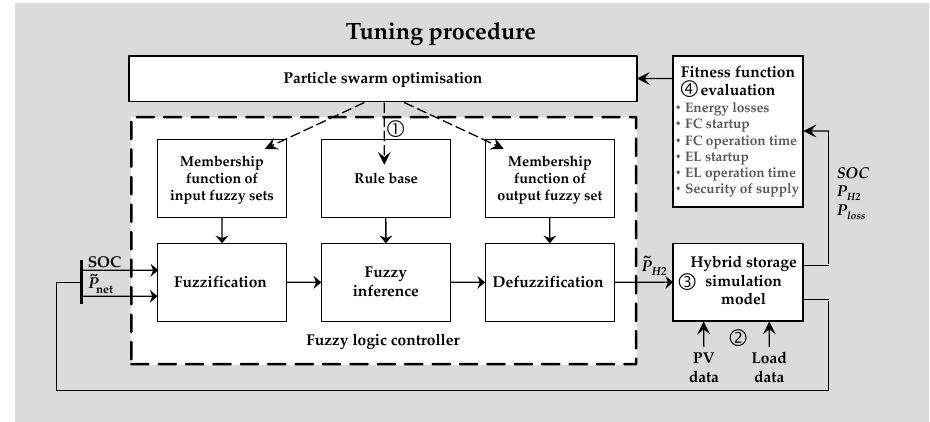
Figure 4. Block diagram of fuzzy logic controller tuning based on particle swarm optimization.